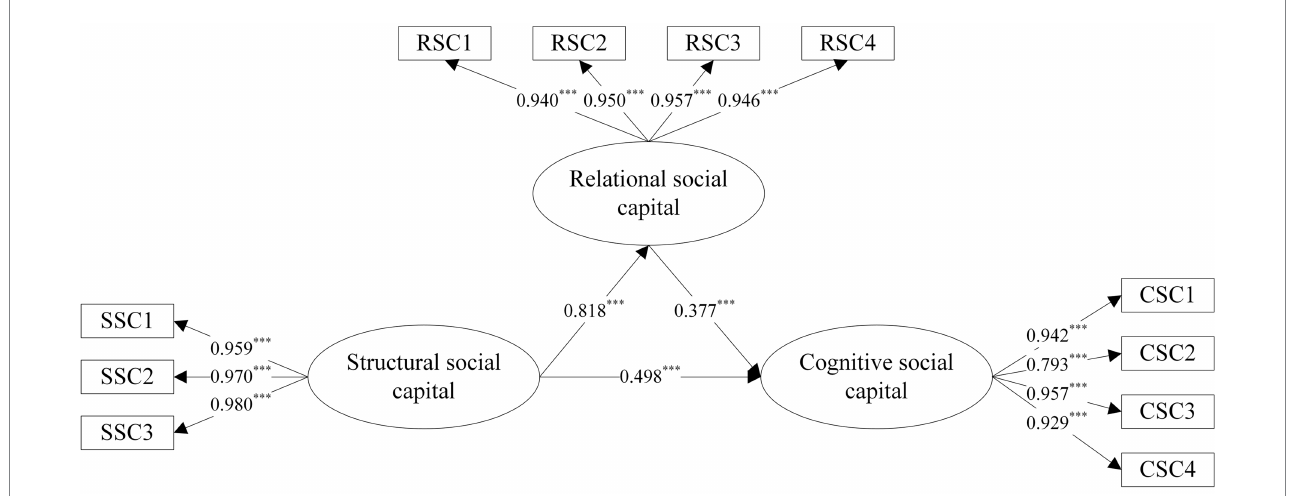
FIGURE 1 Direct effect results. *** p <0.001.